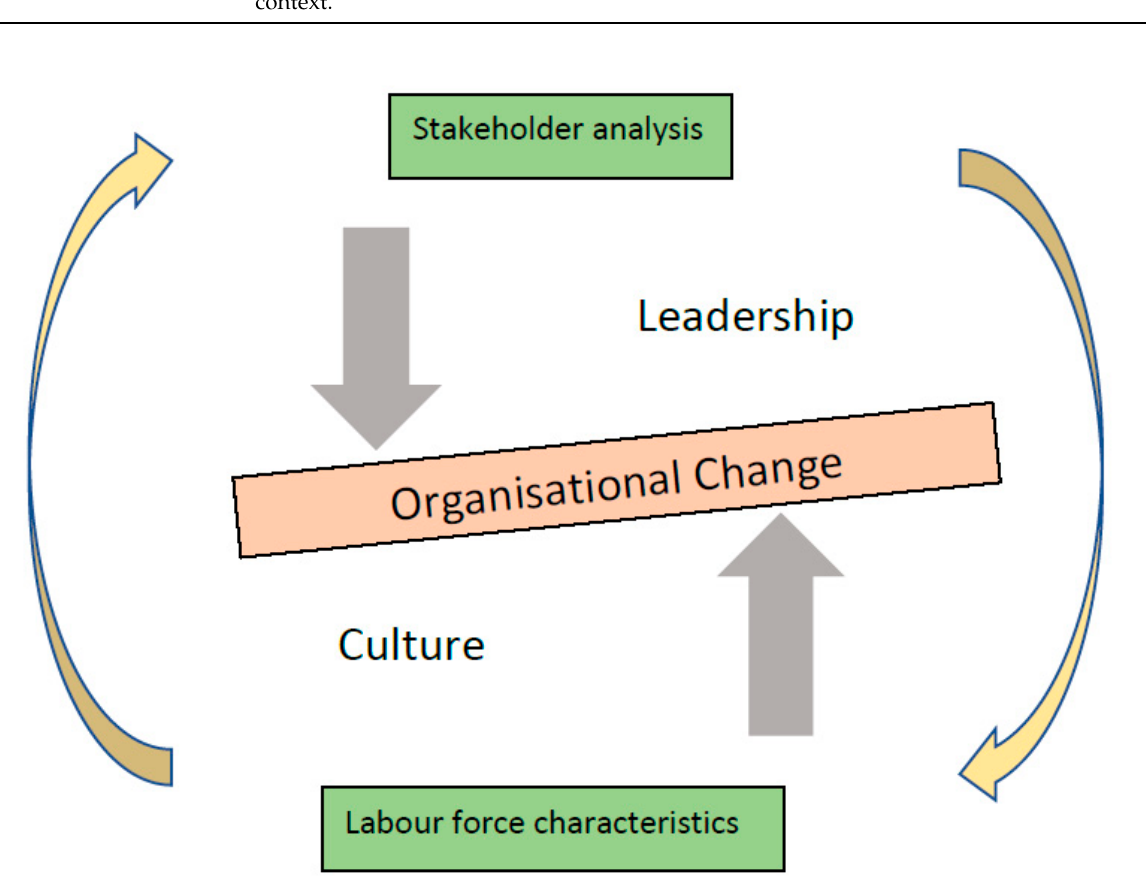
Figure 2. Key considerations in successful organisational change for nonprofit disability service pro- viders.